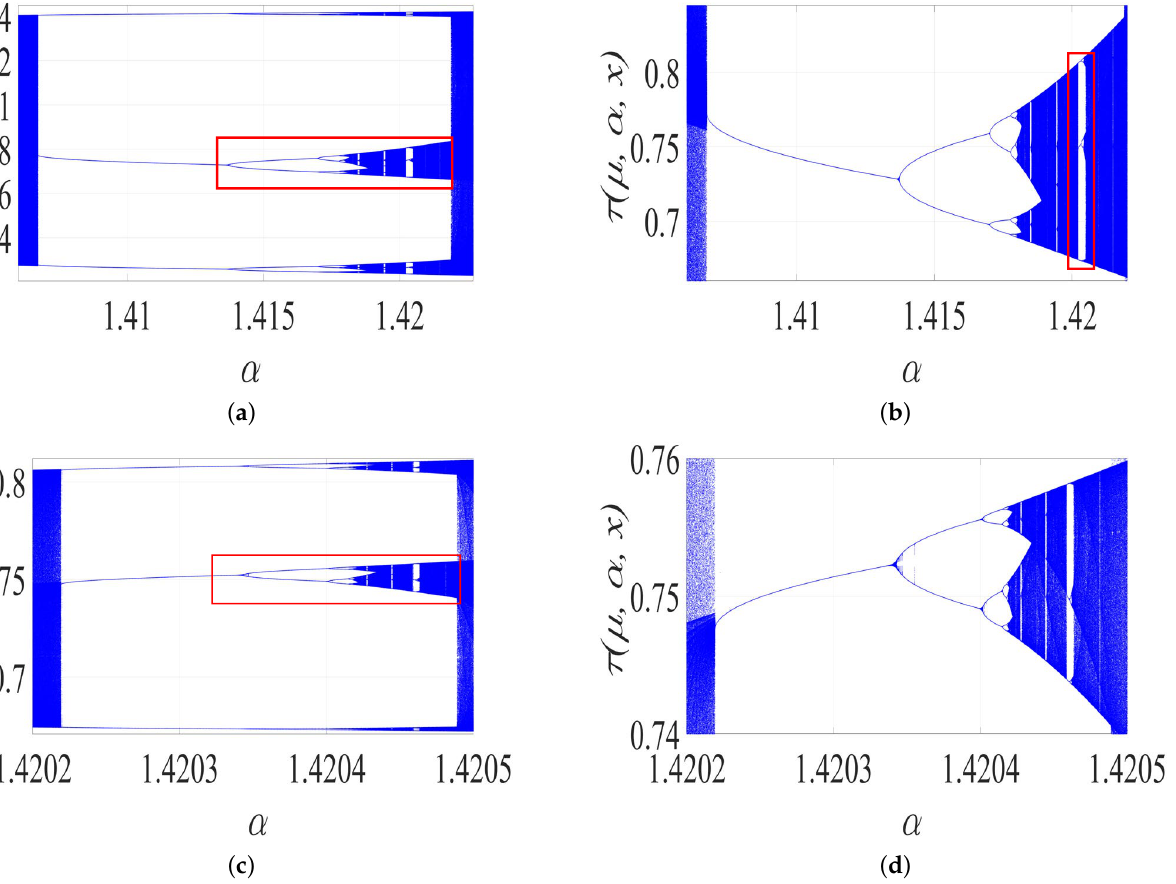
Figure 4. Bifurcation diagram of the FC when µ = 1.5. ( a ) α ∈ ( 1.405,1.425 ) , it corresponds to a close-up on Figure 3c. ( b ) α ∈ ( 1.408,1.422 ) , it corresponds to a close-up on ( a ). ( c ) α ∈ ( 1.402,1.4205 ) , it corresponds to a close-up on ( b ). ( d ) α ∈ ( 1.402,1.4205 ) , it corresponds to a close-up on ( c